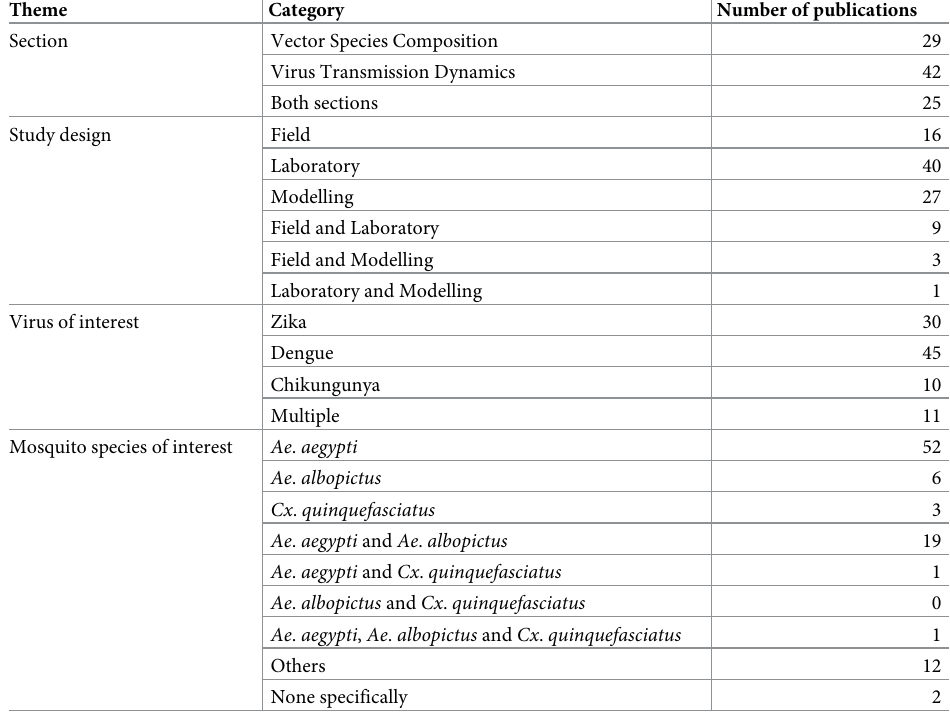
Table 1. Number of publications included in the scoping review, for each review section, study design, and arbovi- rus and mosquito vector species of